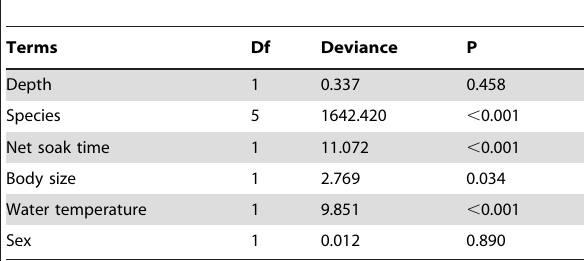
Table 3. Summary of GLM analysis testing the effects of depth, species, net soak time, body size, water temperature and sex on total